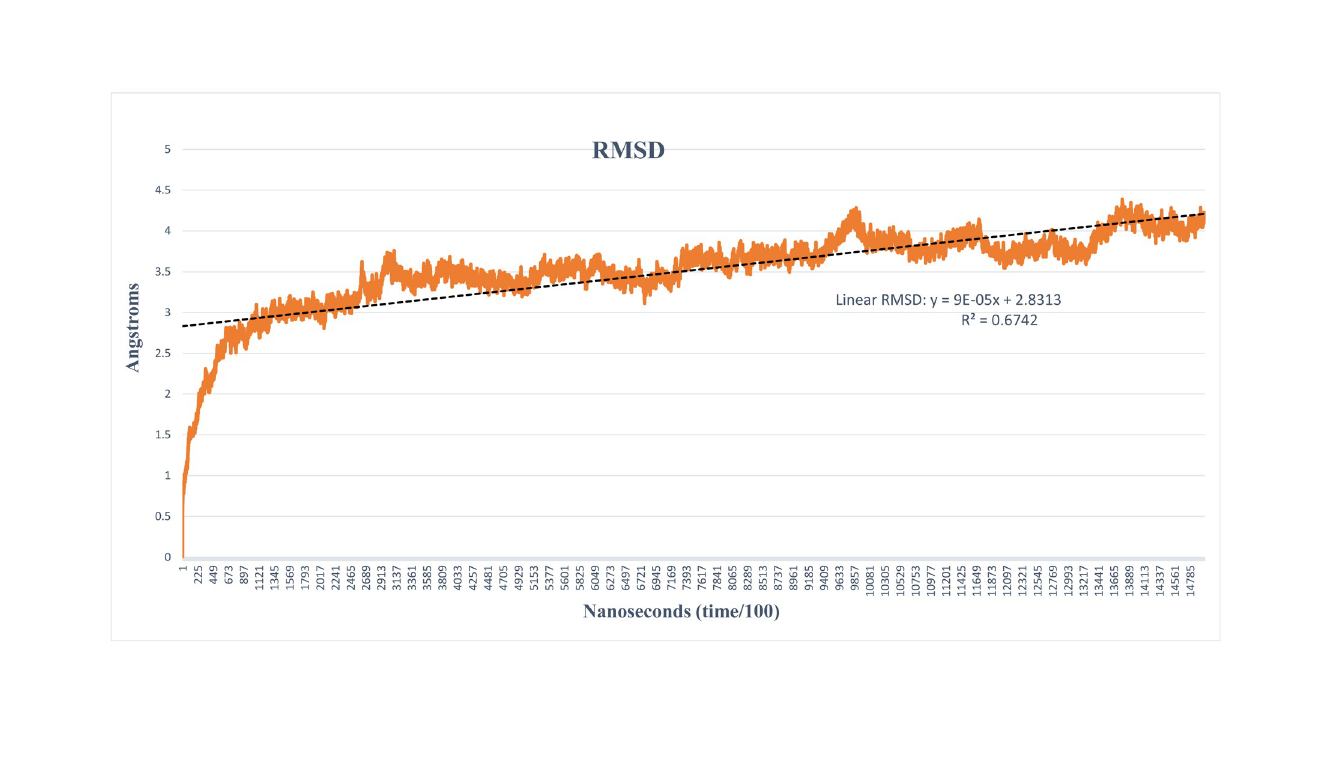
Fig 1. Root mean square deviation graph vs. time; the graph showed the minimal fluctuations throughout the simulation runs and structural stability and optimization were achieved with respect to time.